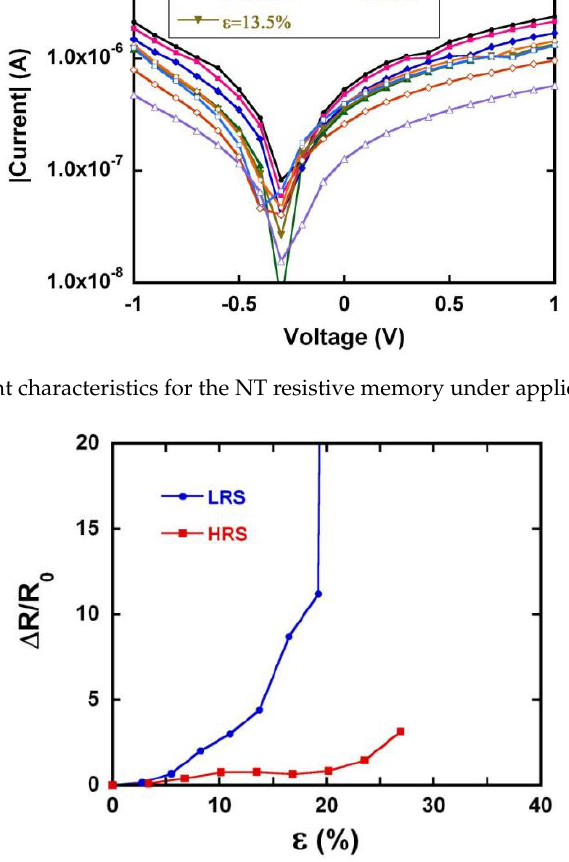
Coatings 2019 , 9 , x FOR PEER REVIEW 5 of 7